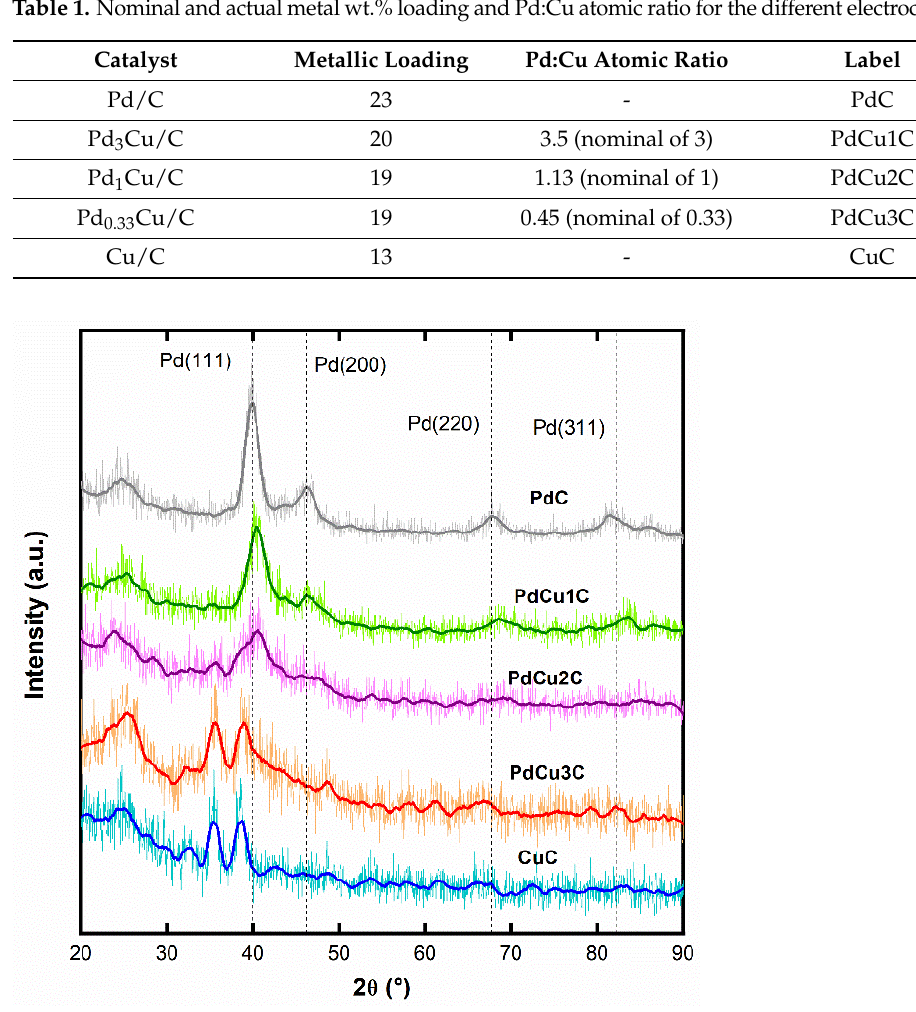
Figure 1. XRD patterns of the different electrocatalysts.